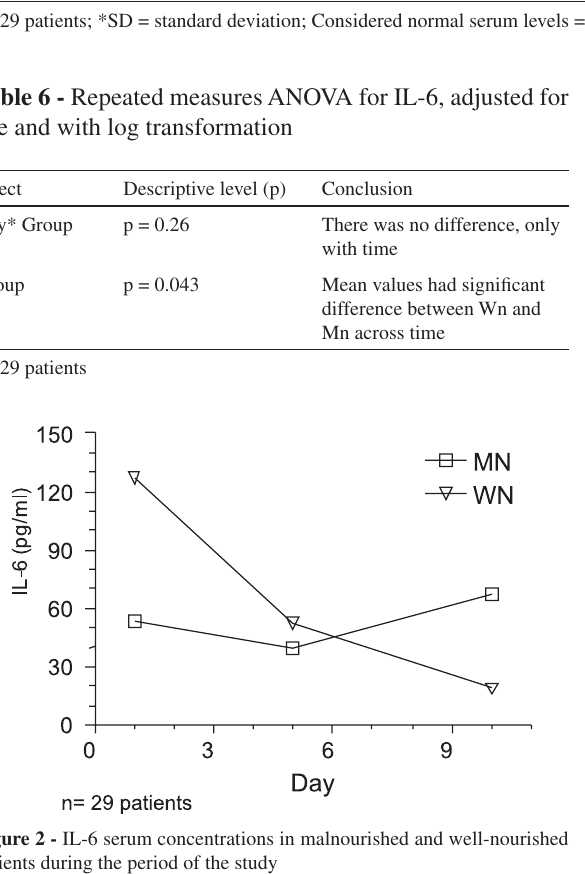
Table 5 - Descriptive statistics with estimated marginal means of IL-6 Day